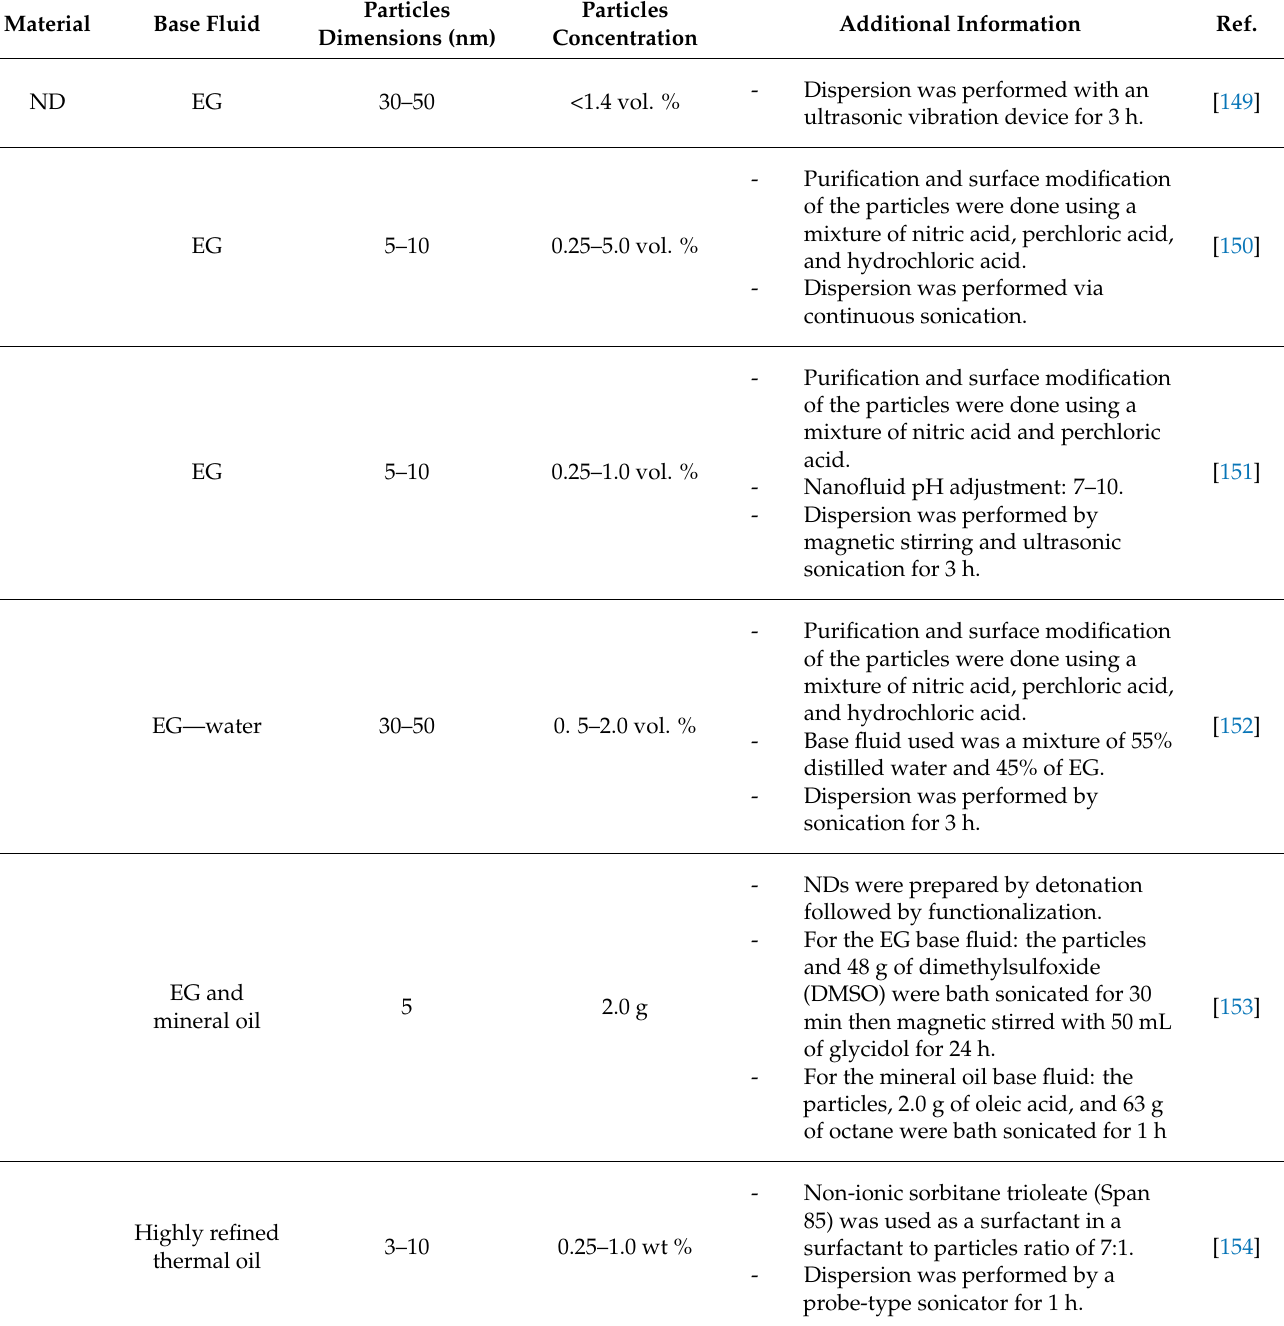
Table 2. Published work on nanodiamond, graphene, and carbon nanotubes nanofluids produced using the two-step ap-